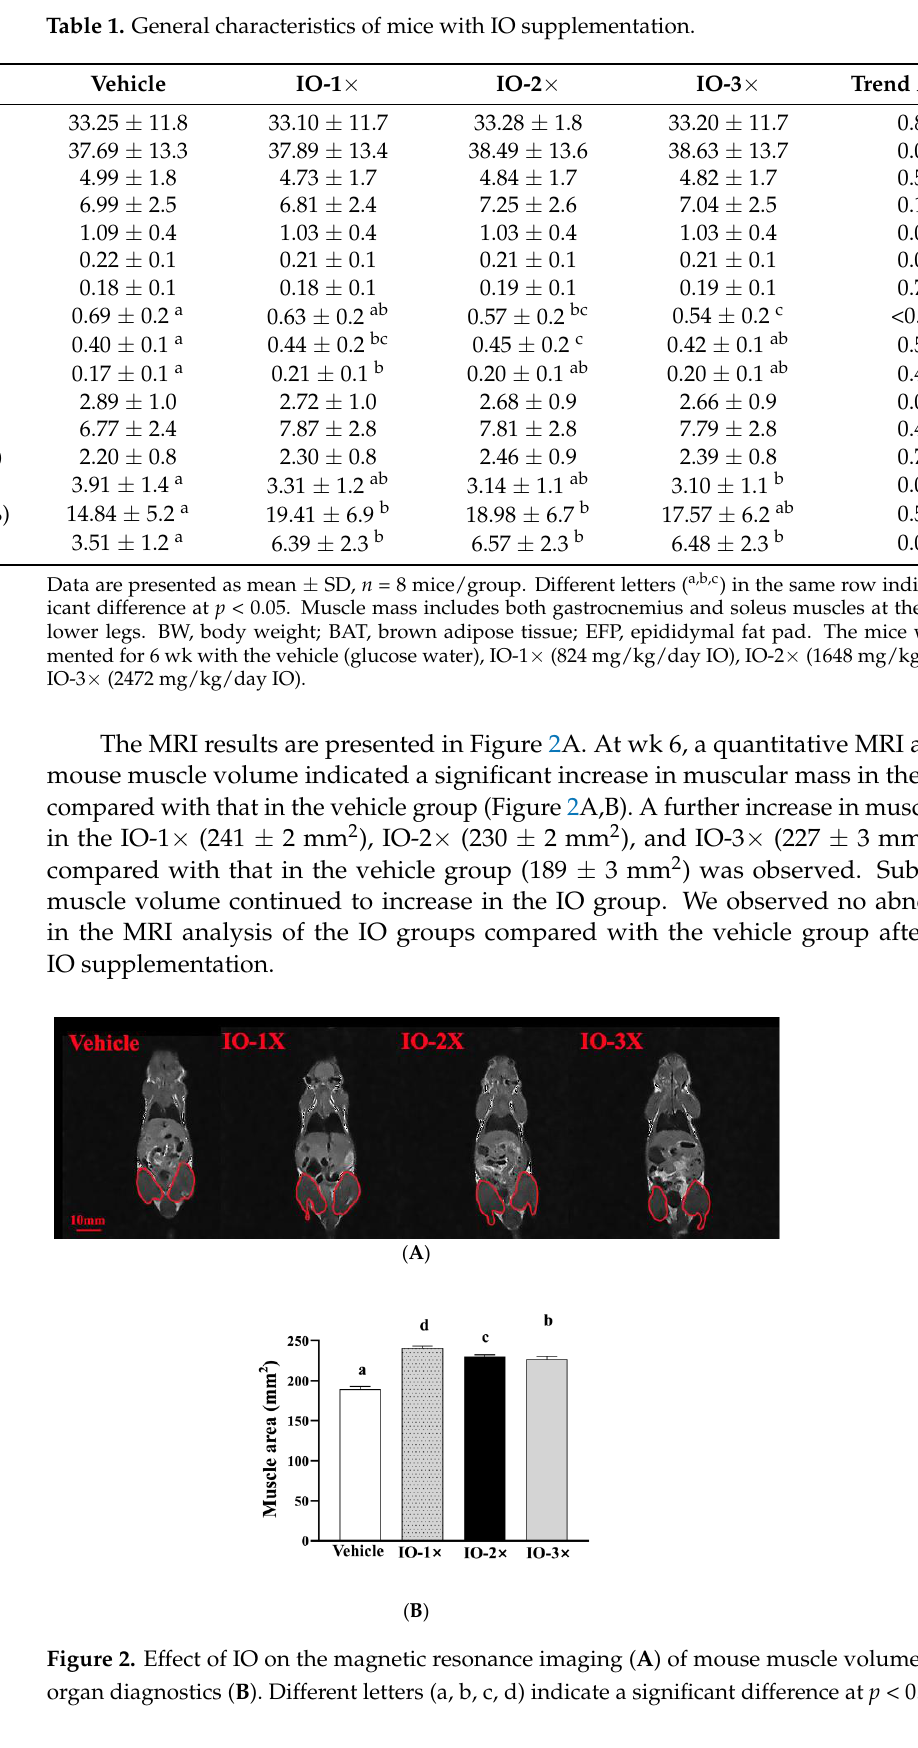
Table 1. General characteristics of mice with IO supplementation.